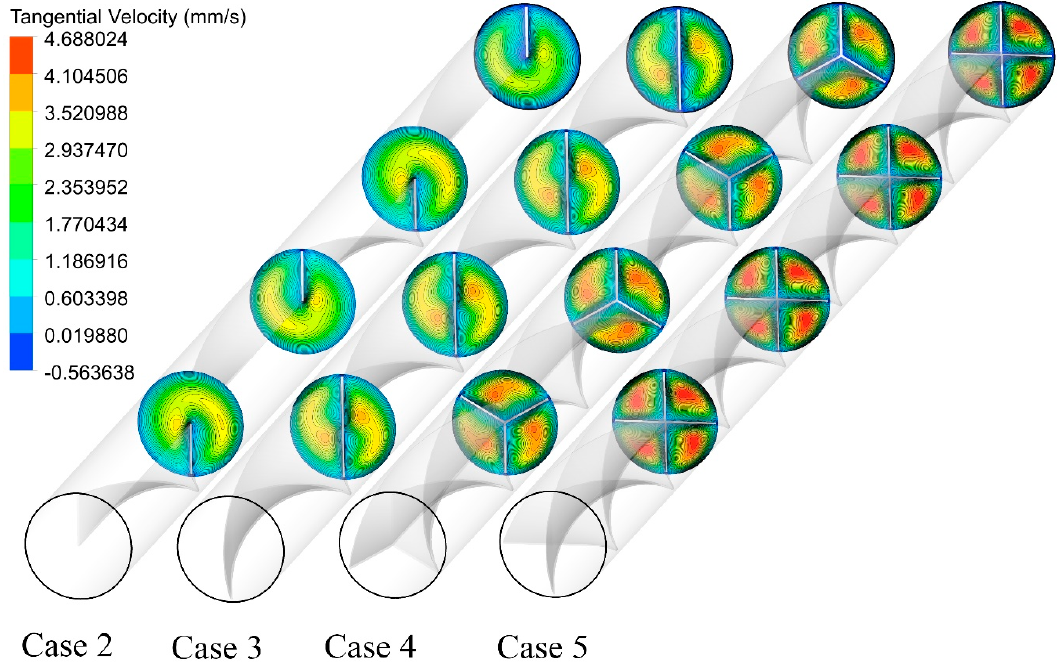
Figure 10. Cross-sectional tangential velocity contours for the captured cases at Re = 250 and φ = 0%.